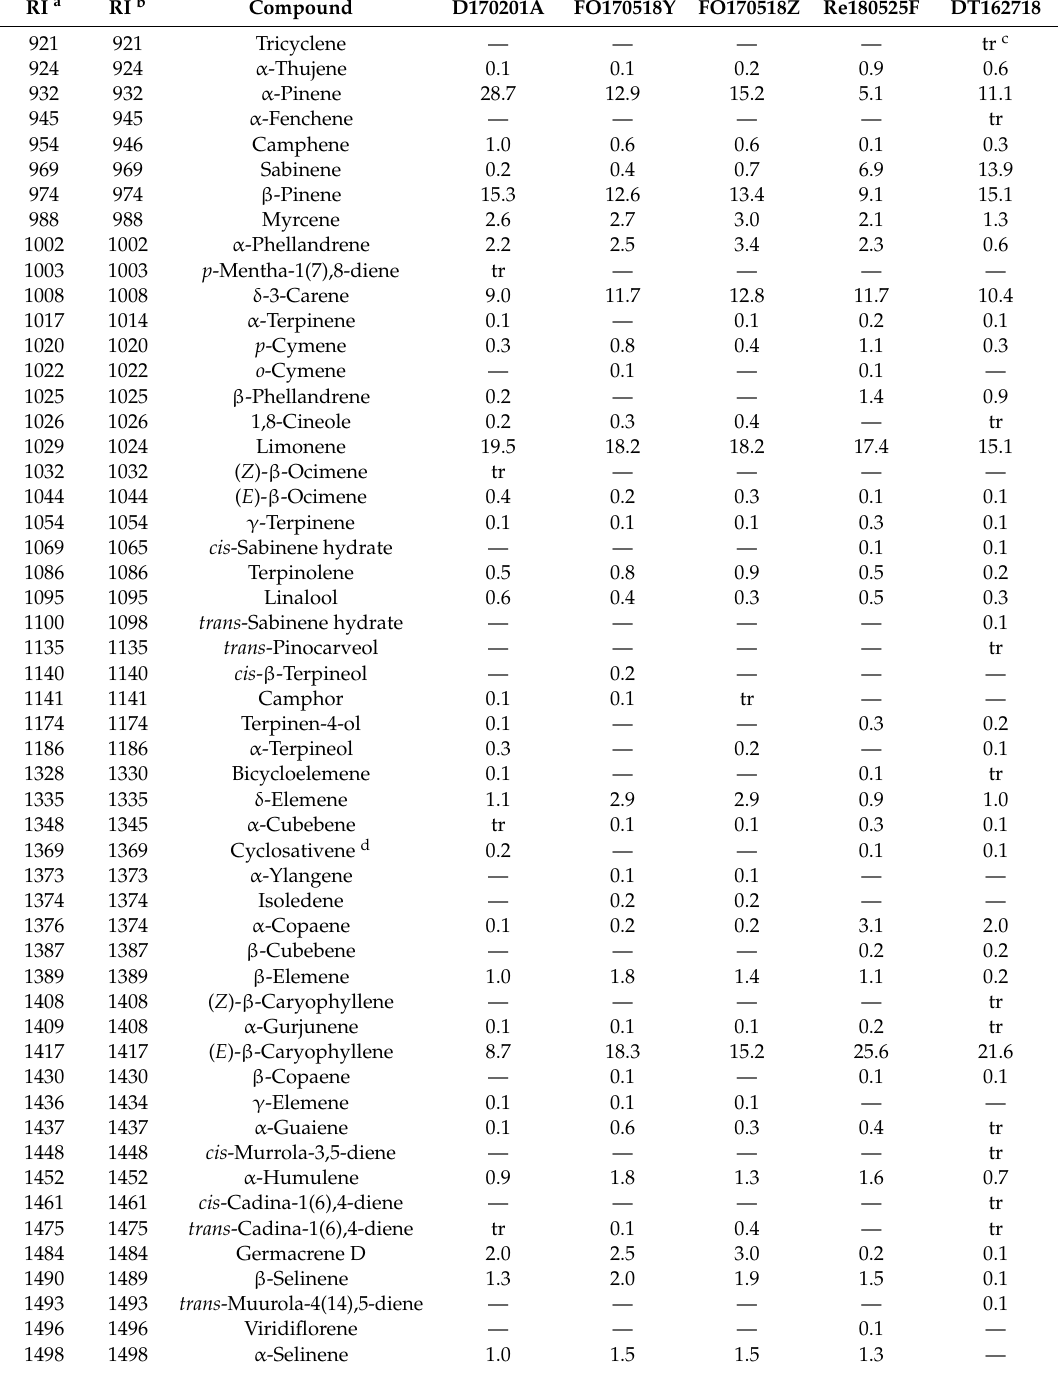
Table 1. Chemical compositions of Piper nigrum fruit volatile oils from the Aromatic Plant Research Center (APRC)